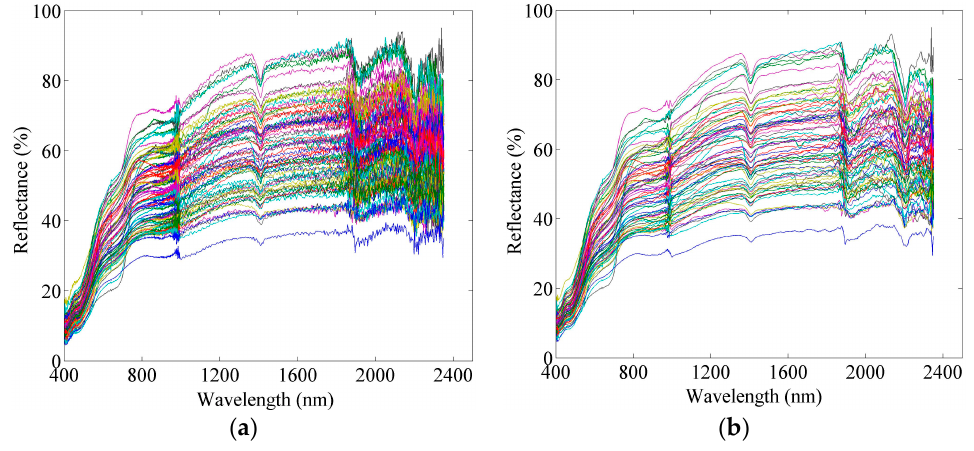
Figure 2. Seventy-four soil reflectance spectra: ( a ) original spectra and ( b ) spectra processed by piecewise Savitzky-Golay smoothing.